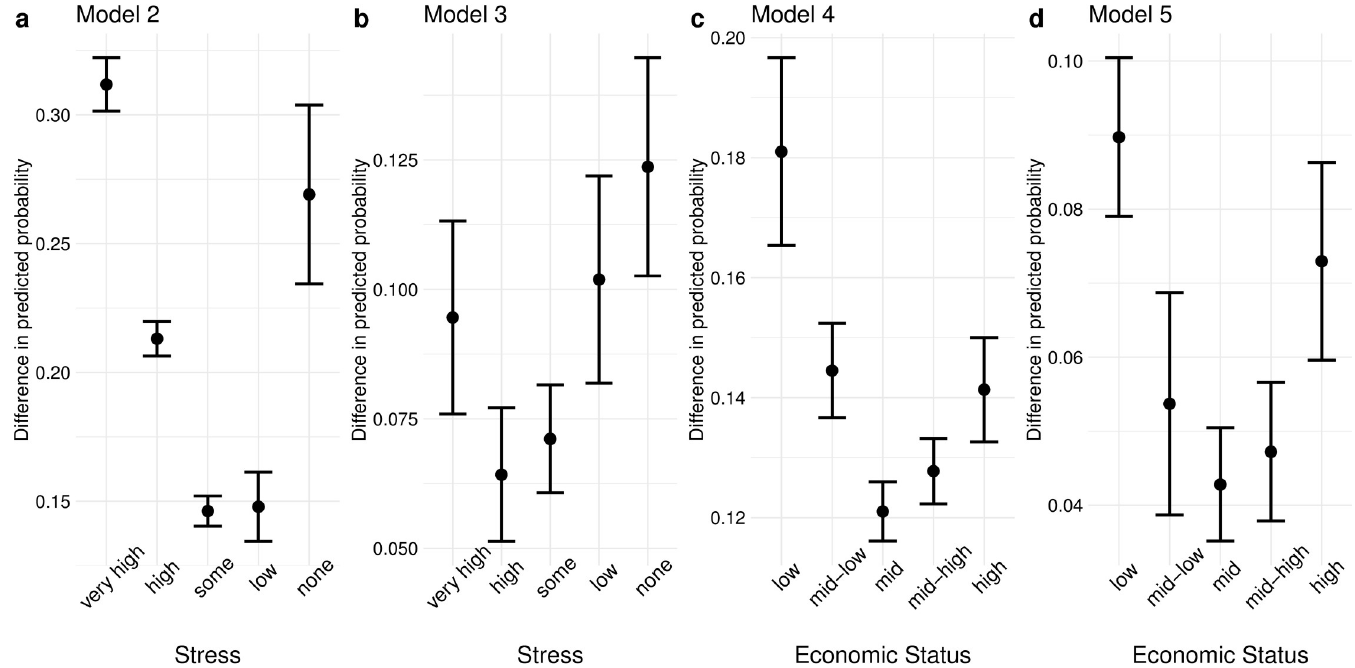
Fig 4. Risk difference for each category of stress and economic status. All covariates not involved in the interaction were set to zero or the reference category. Standard errors were estimated with the delta method. Error bars indicate 90% confidence intervals.